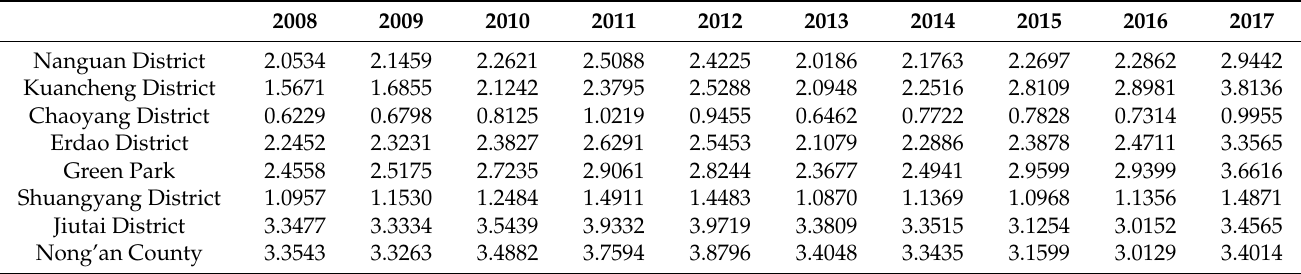
Table A3. The local Moran’s I indexes of the Harbin–Changchun urban agglomeration from 2008 to 2017.